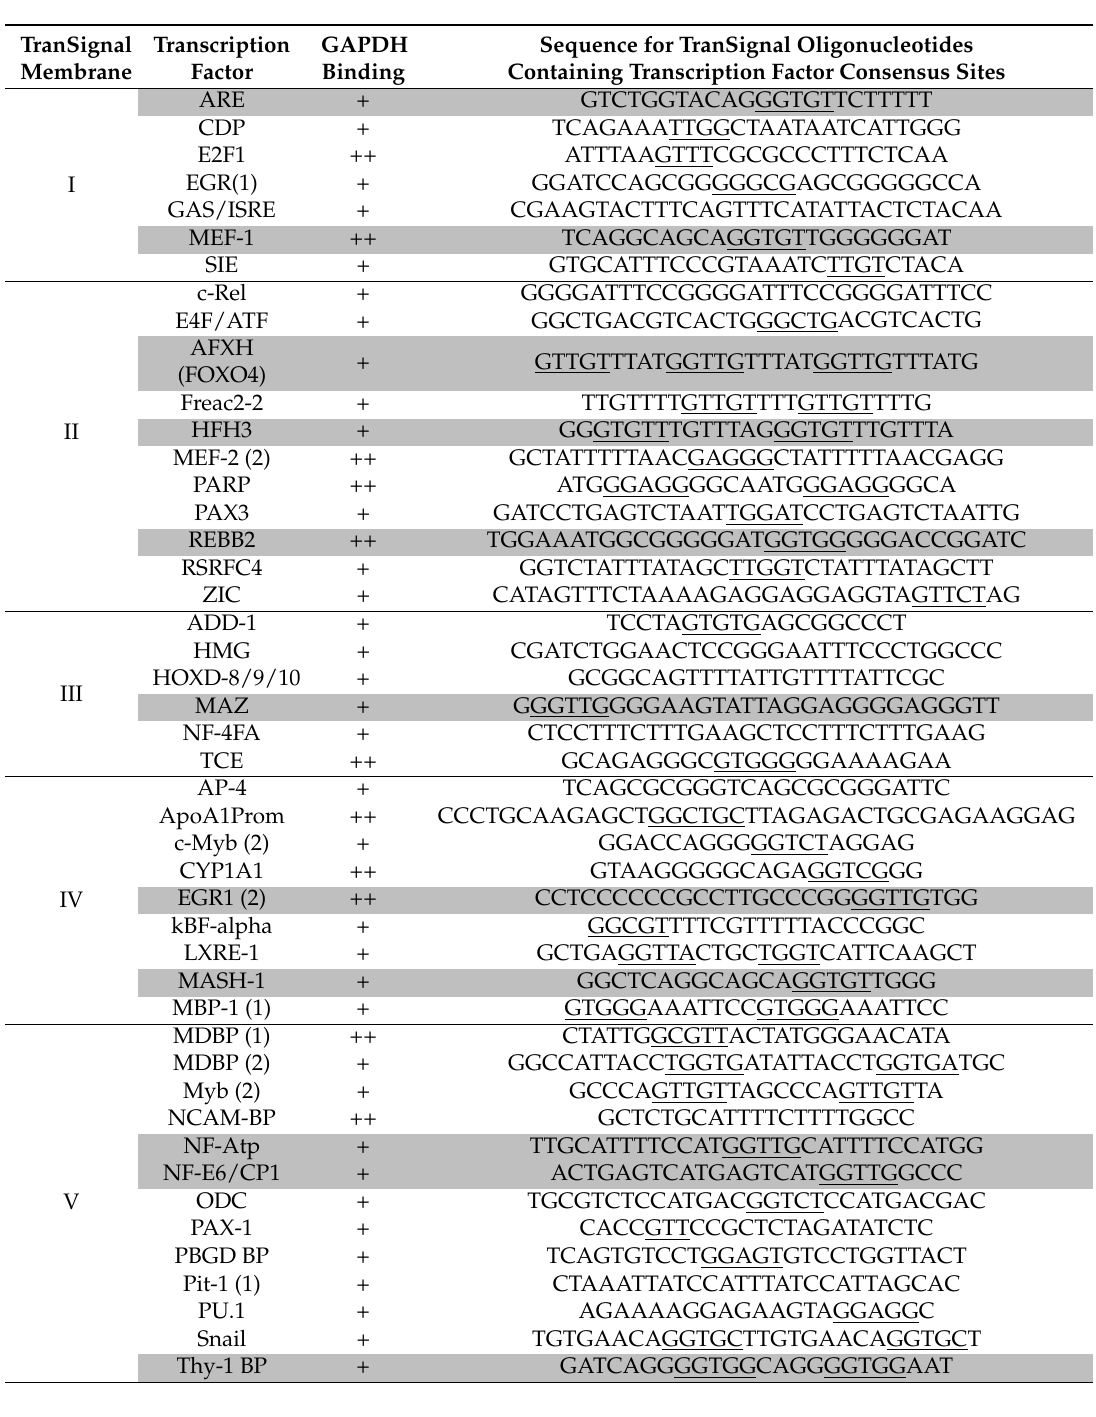
Table 1. Sequences of the bound oligonucleotides. The name and sequences of oligonucleotides correspond to that that formed a GAPDH/DNA complex formed a revealed using Transignal membranes presented in Figure 7. In grey: sequences that contains the 5 1 -GGT(G/T)(G/T) site. Underlined: potential GAPDH binding sites from comparison with sequences obtained from SELEX. “+” and “++” refers to strong and very strong binding of GAPDH to DNA at the indicated